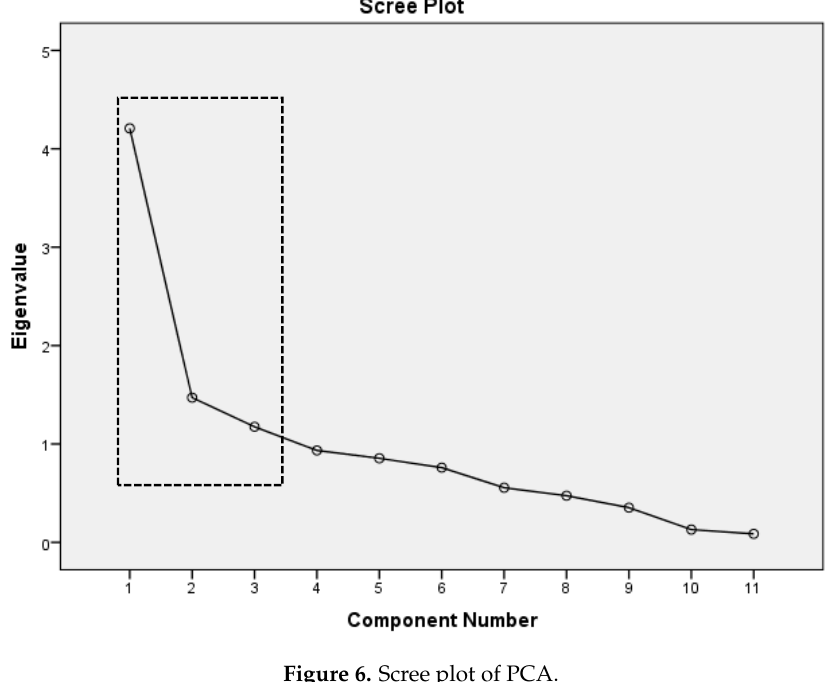
Figure 6. Scree plot of PCA. Table 4. Initial eigenvalues and selected component loading after varimax rotation for PCA results in the Erren River.